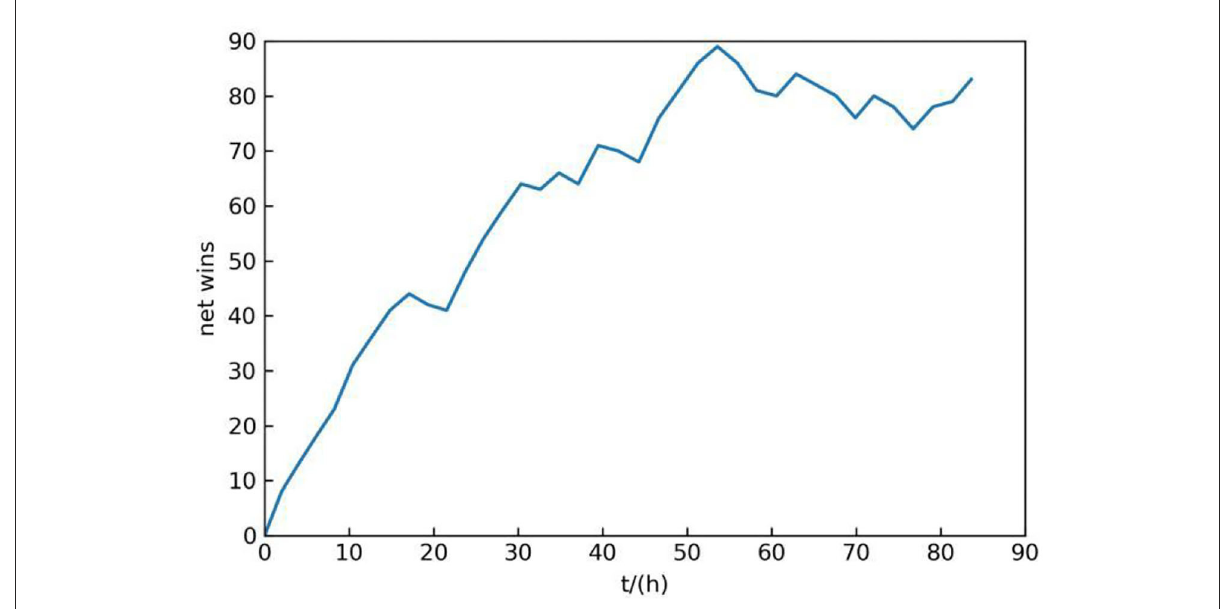
FIGURE6 Neural networks training